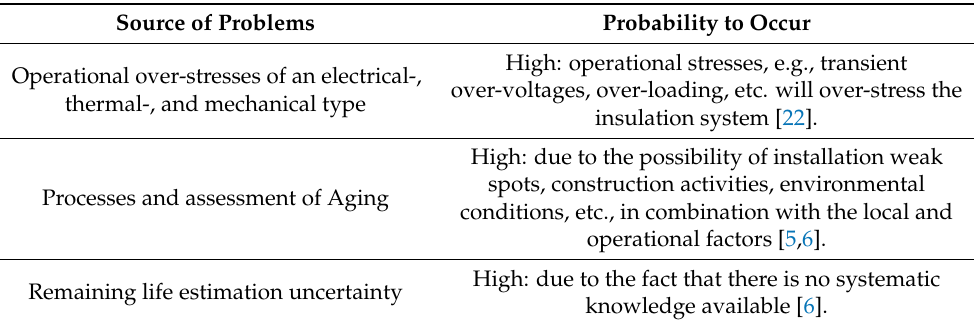
Table 4. Examples of operational hazards of long-length power cables for offshore application.